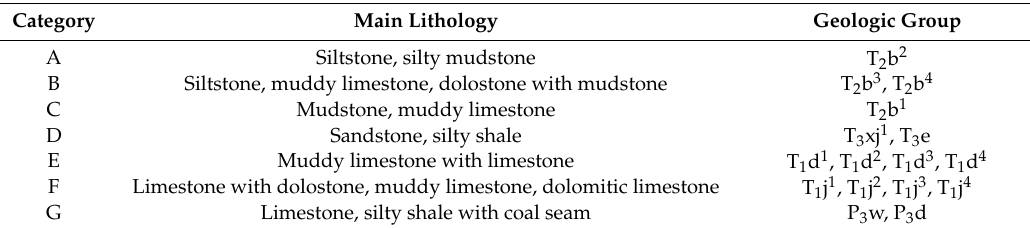
Table 2. Lithological classification in the study area.